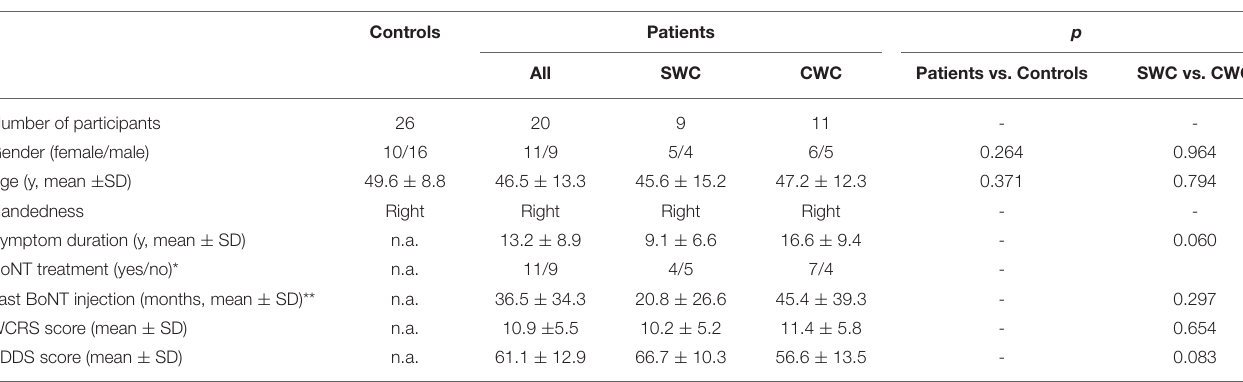
TABLE 1 | Participant